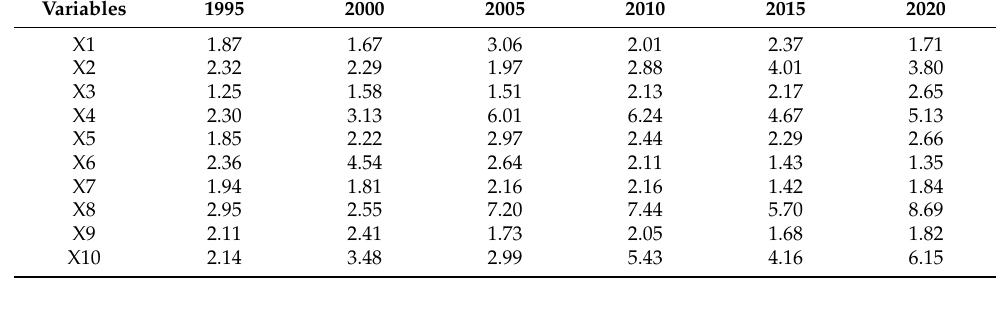
Table A2. Variables of the covariance diagnosis in 1995, 2000, 2005, 2010, 2015 and 2020.